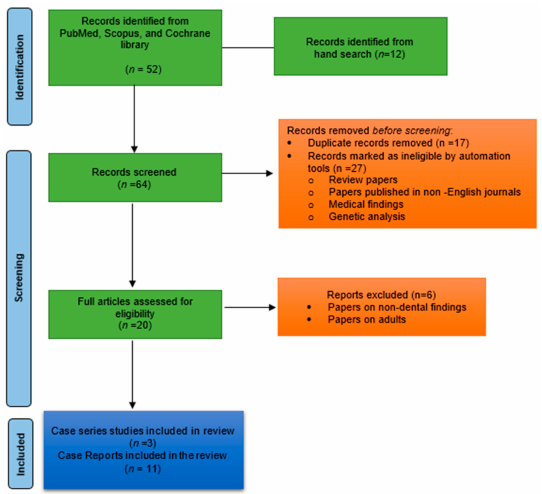
Figure 1. PRISMA 2020 flow diagram used in the review